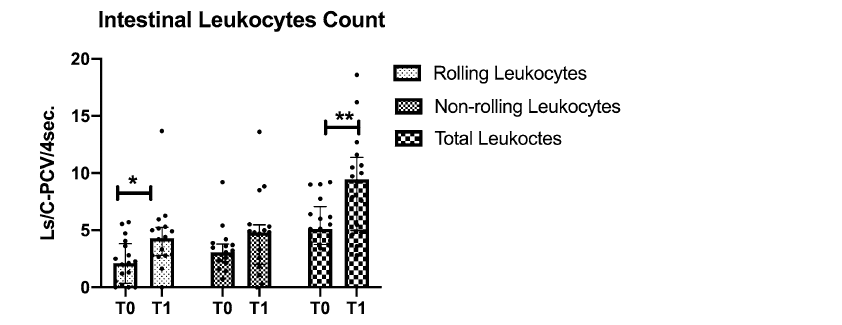
Figure 6. Leukocyte quantification in the intestinal serosa assessed at the beginning of surgery (T0) and end of surgery (T1). The microcirculatory rolling leukocytes count increased during surgery. Values are represented as median [interquatile], * p < 0.05, ** p <